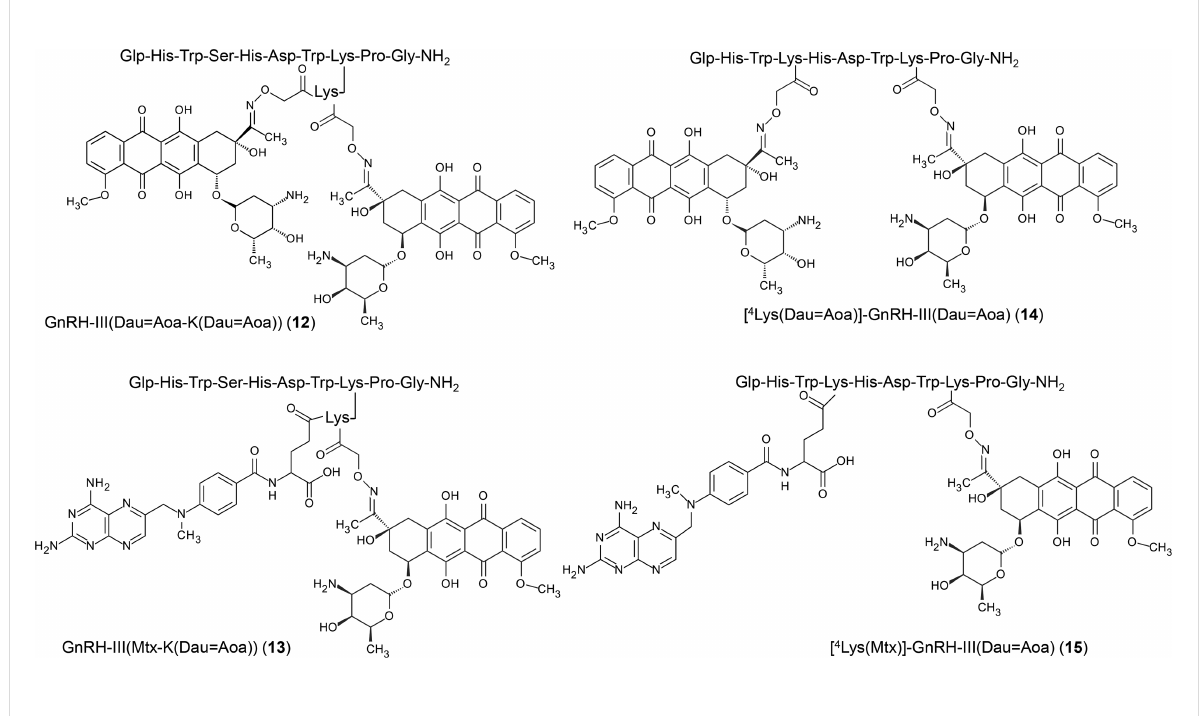
Figure 2: Chemical structures of the bifunctional GnRH-drug conjugates synthesized and investigated in the present work. Abbreviations: Aoa: aminooxyacetyl; Dox: doxorubicin; Dau: daunorubicin; Mtx: methotrexate; Glp: pyroglutamic acid.